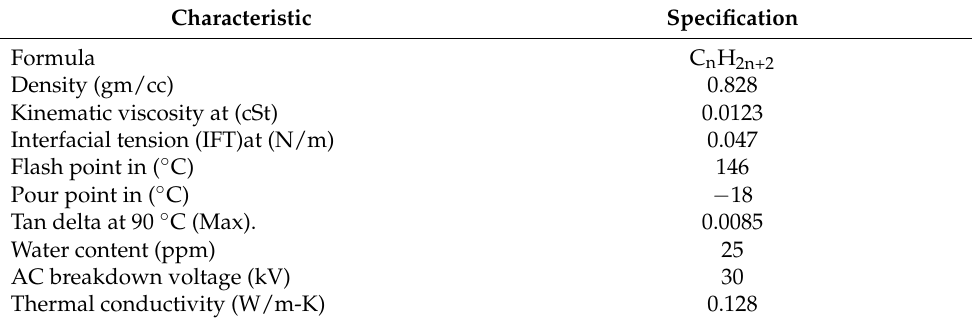
Table 1. Specifications of